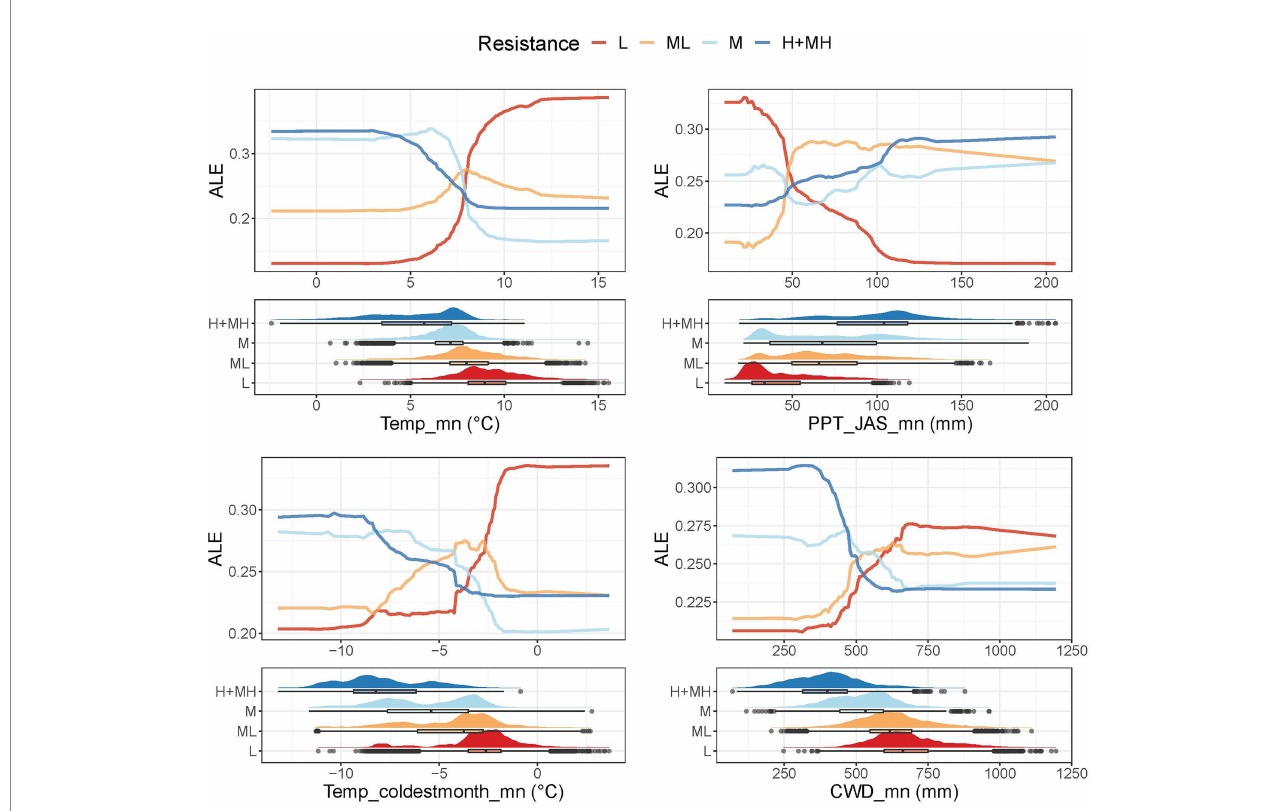
FIGURE 4 Accumulated local profile (ALE) plots and halfeye/box plots for the most highly ranked predictors of resistance. The ALE plots show effects of the focal variable on the random forest classification conditioned on the effects of other variables in the model. Halfeye/boxplots illustrate density of the raw data combined with a boxplot showing the median at the box’s center, the first and third quartiles (25th and 75th percentiles) as the box’s hinges, and whiskers extending to the largest and smallest values no further than 1.5 times the interquartile range from the hinge. Additional outliers are plotted as open